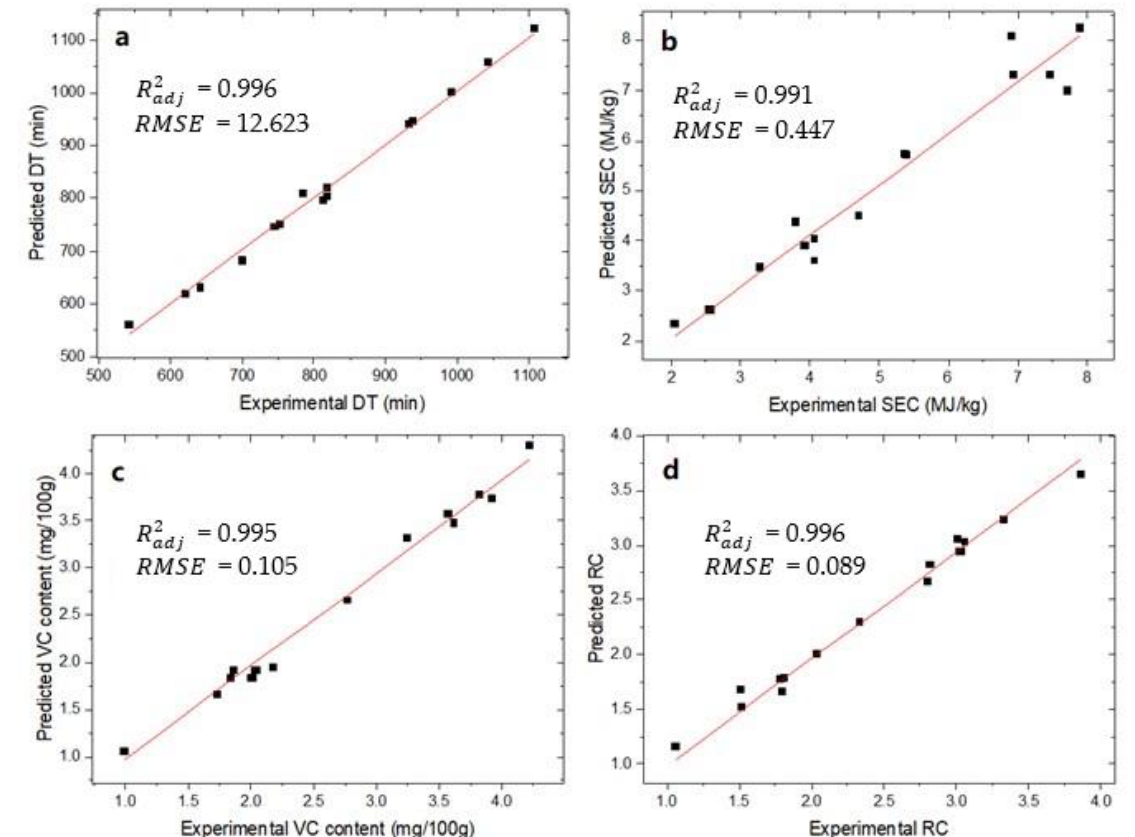
Figure 8. Experimental data and predicted values from ANN model of response variables: ( a ) drying time; ( b ) specific energy consumption; ( c ) ascorbic acid content; and ( d ) rehydration capacity.